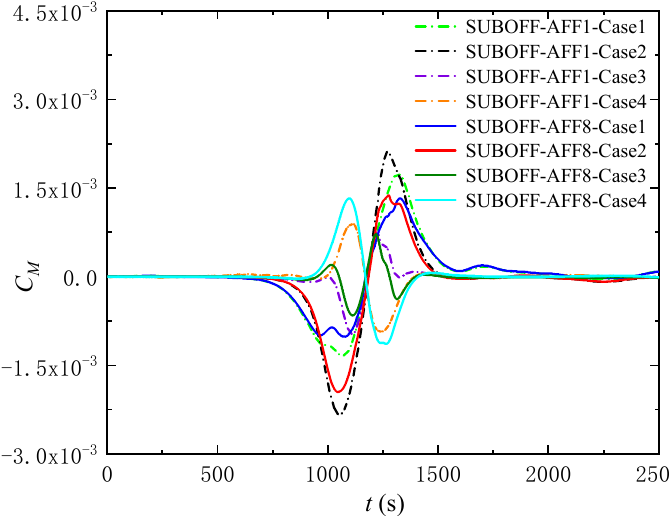
Figure 21. Nondimensional moment for SUBOFF (S = 0.466).